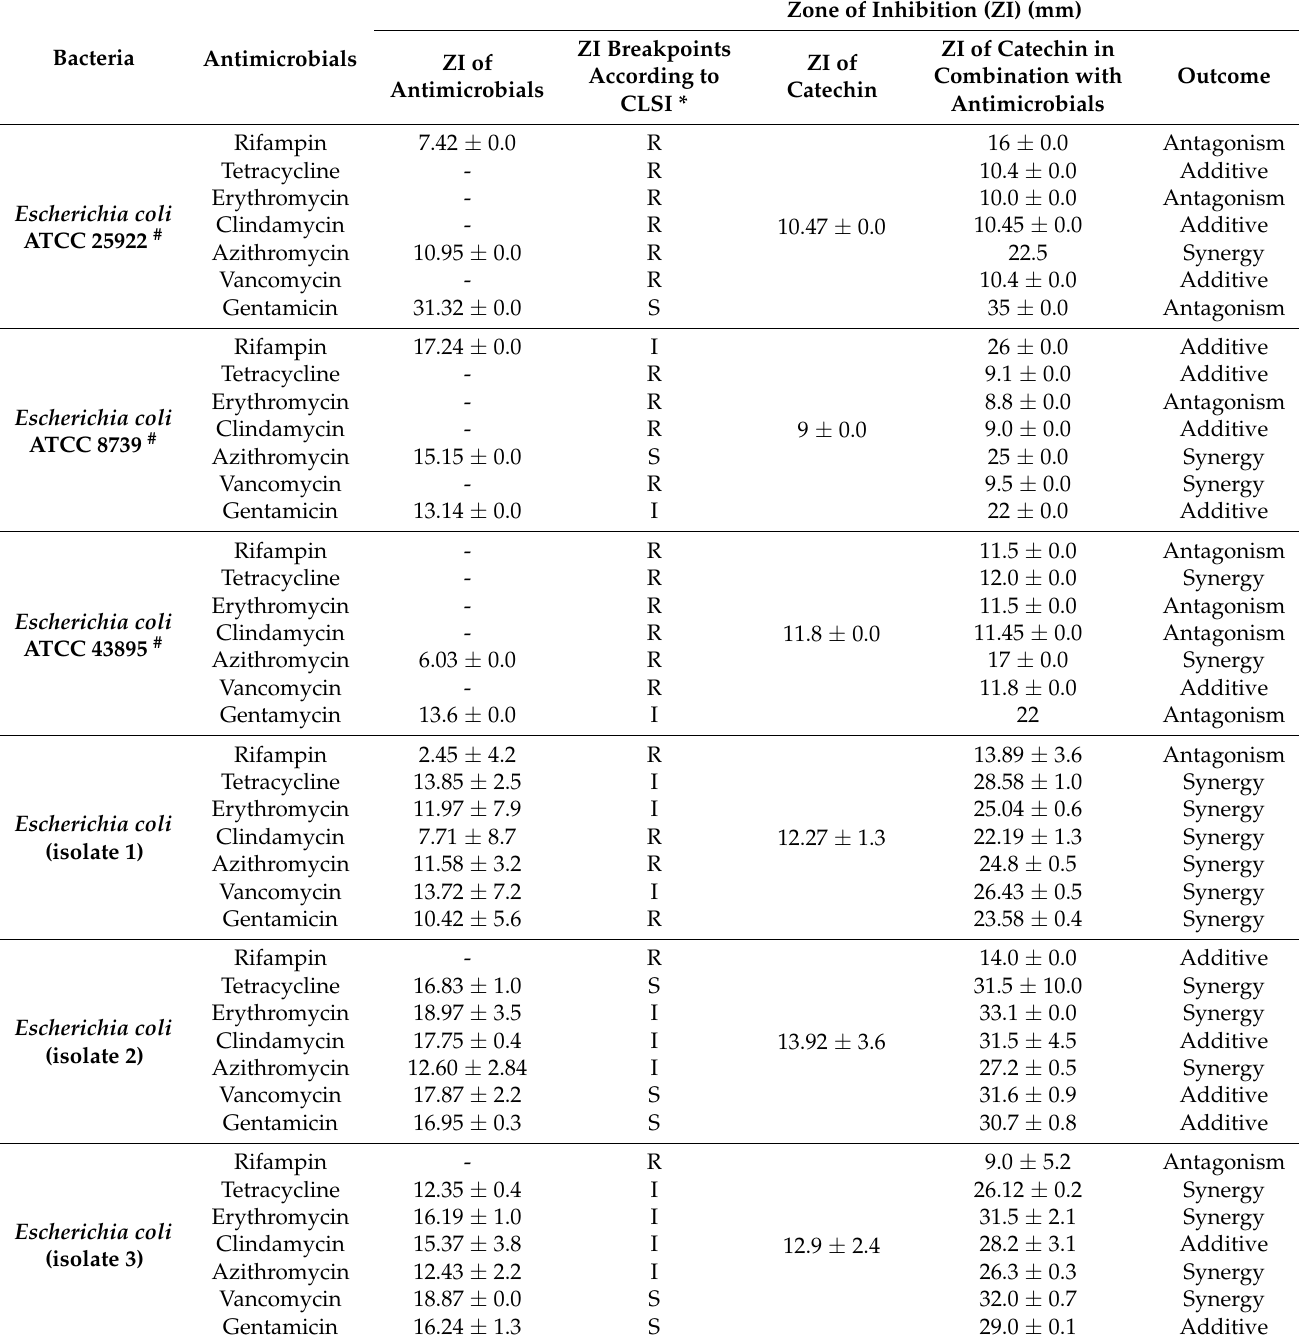
Table 1. Zone of inhibition (mm) for the antimicrobial agents and catechin alone and in combination against E. coli